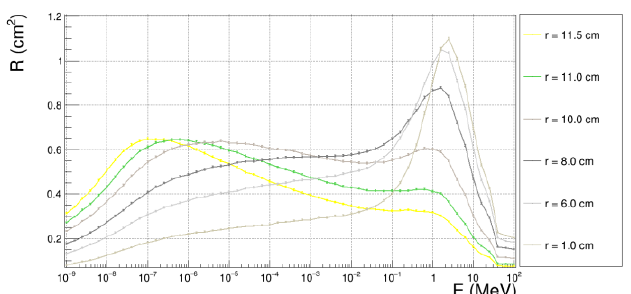
Fig. 5. Response matrix (cm²) as function of energy (MeV) obtained for the 6 groups of